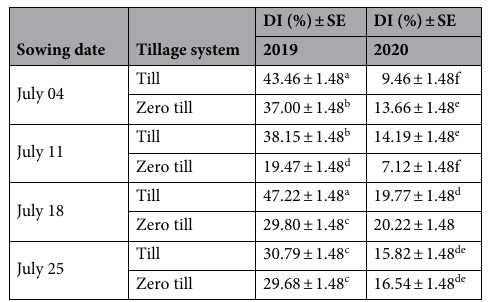
Table 2. Assessment of disease incidence at sowing dates in the trial study. SE Standard Error; DI Disease incidence. a, b, c, d, e, f means in the columns with the same superscript are not significantly different at p < 0.05 (DMRT).